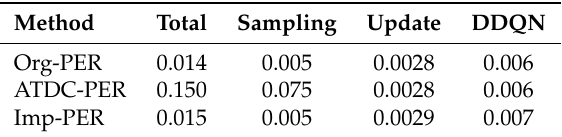
Table 4. The time cost in each algorithm (s) on Atari with DDQN. The total time also includes other processes which are not the main